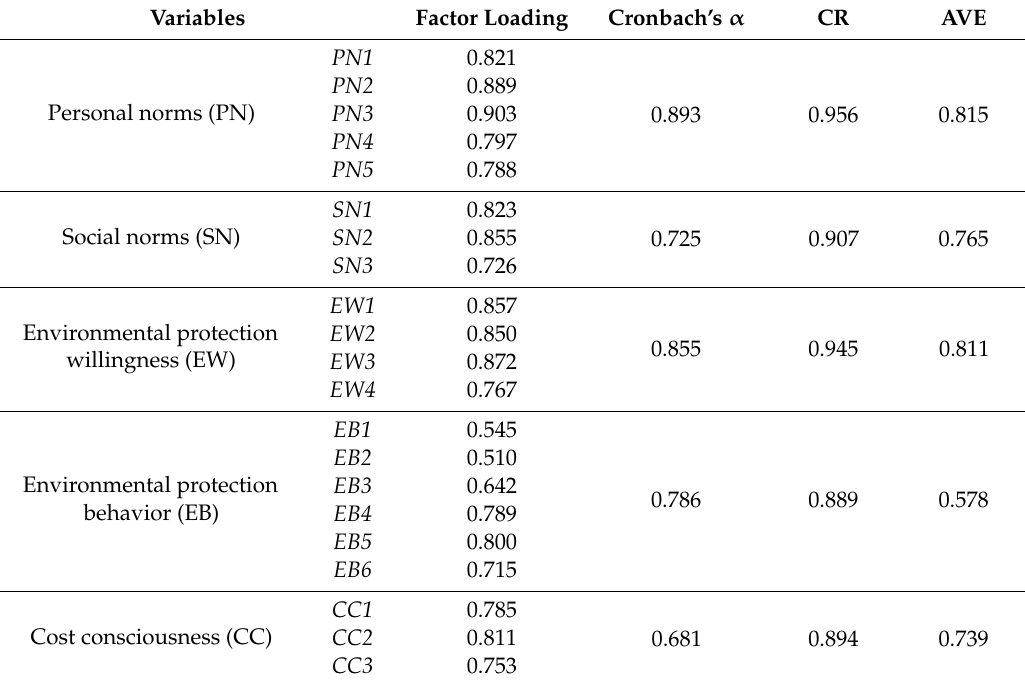
Table 1. Reliability and validity analysis results.